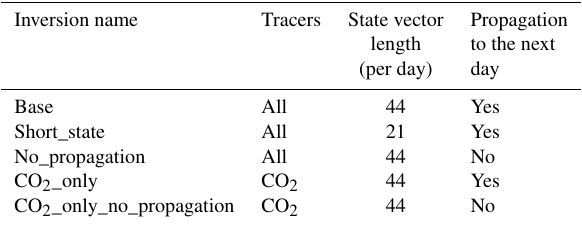
Table 2. Overview of the inversions: which tracers are included, the length of the state vector, and whether posterior values and uncer- tainties are